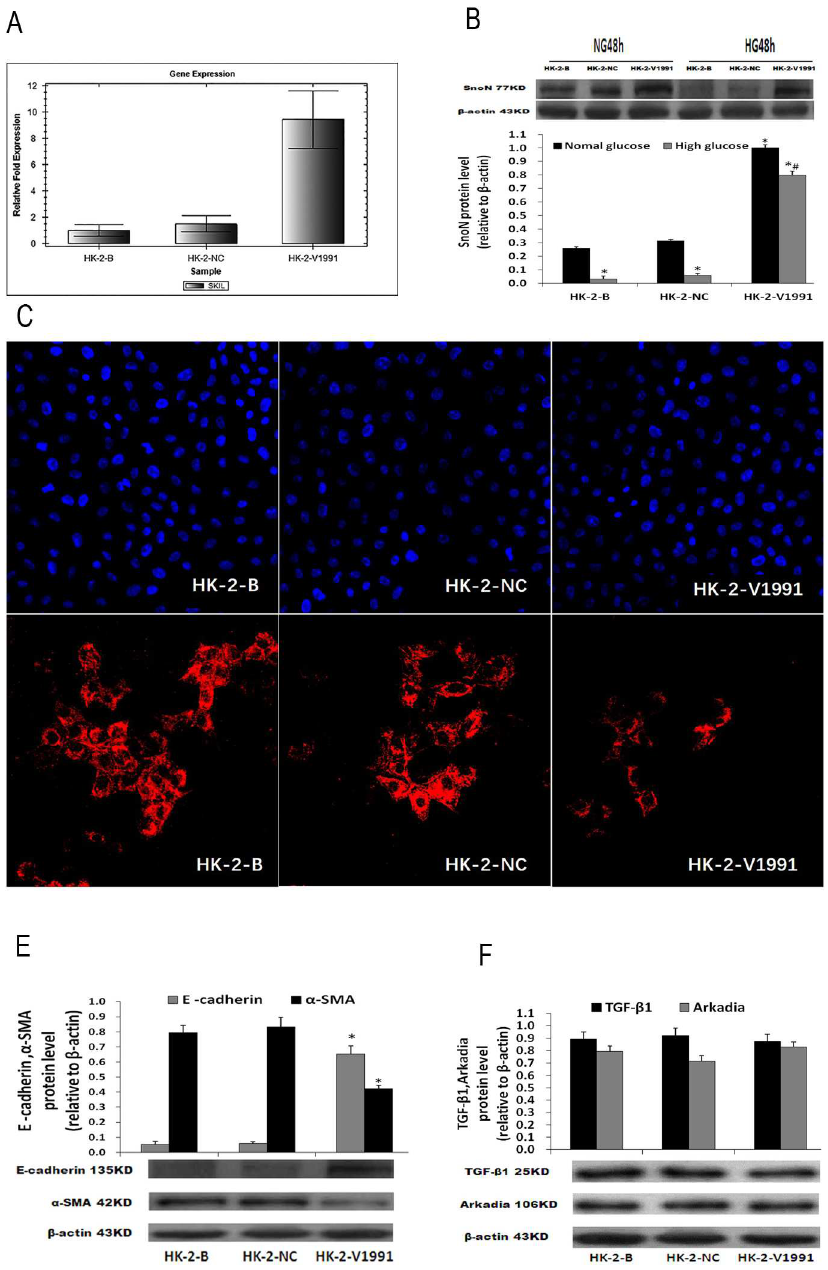
Fig 6. Dominant expression of SnoN protects renal tubular cells from EMT under high glucose stress. A, Gene expressionlevels of hSKIL in HK-2 cells after transfection(72h). B, Protein expressionof SnoN in HK-2 cells treated with 25 mmol/L glucoseor 5.5 mmol/L glucosefor 48h. C, Expression of α -SMA in HK-2 cells treated with 25 mmol/L glucosefor 48h assessed under an invertedfluorescence microscope (200 × ) (red, α -SMA; blue, nucleus). D, Protein expressionlevels of E-cadherinand α -SMA in HK-2 cells treated with 25 mmol/L glucosefor 48h. E, Protein expressionlevels of TGF- β 1 and Arkadia in HK-2 cells treated with 25 mmol/L glucosefor 48h. * P < 0.05 comparedto the NG-HK-2-B group; # P < 0.05 compared to the HG-HK-2-B group.